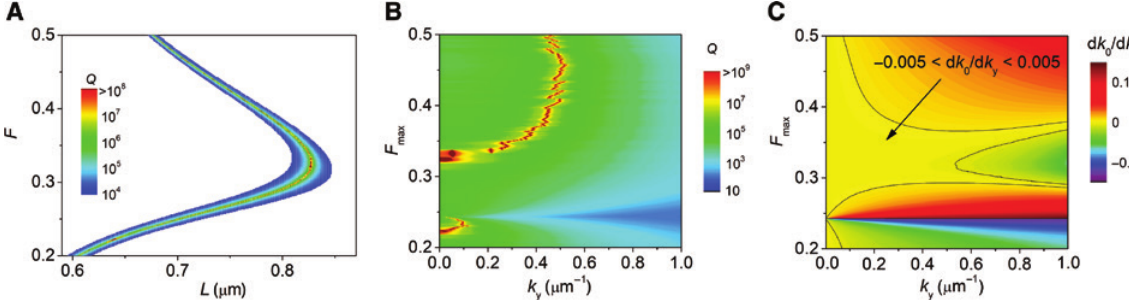
Figure 9: Q -factor of M-M microcavity for (A) vertical wavevector and (B) tilted wavevector. (C) Derivative of M-M microcavity wavenumber as the function of lateral component of wavevector. (A) Q -factor represented by colors of an infinitely periodic M-M microcavity in the domain of the MHCG period ( L ) and duty cycle ( F ) when = 163.9 nm. (B) Q -factor values represented by colors and (C) derivative of the wavenumber ( k h M the wavevector ( k ) in the domain of MHCG duty cycle ( F ) and lateral component of the wavevector. Each F y of the largest Q -factor for a given F extracted from (A).